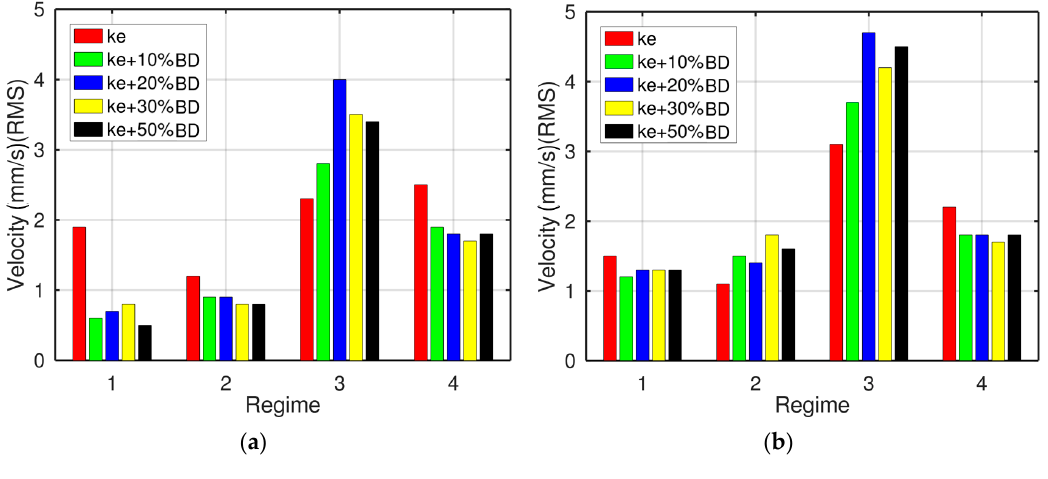
Figure 12. Vibration levels axial ( a ) and radial ( b ).